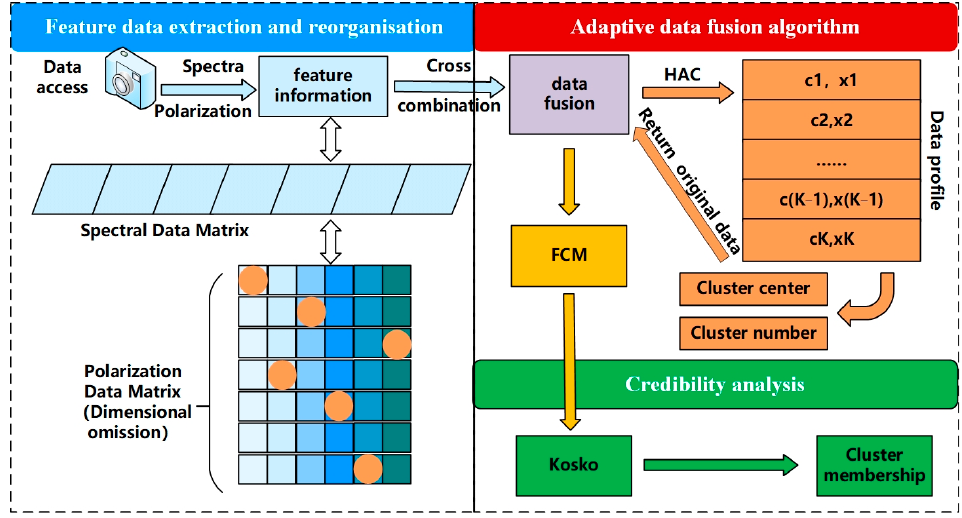
Figure 1. Schematic diagram of HAC-FCM clustering algorithm structure .